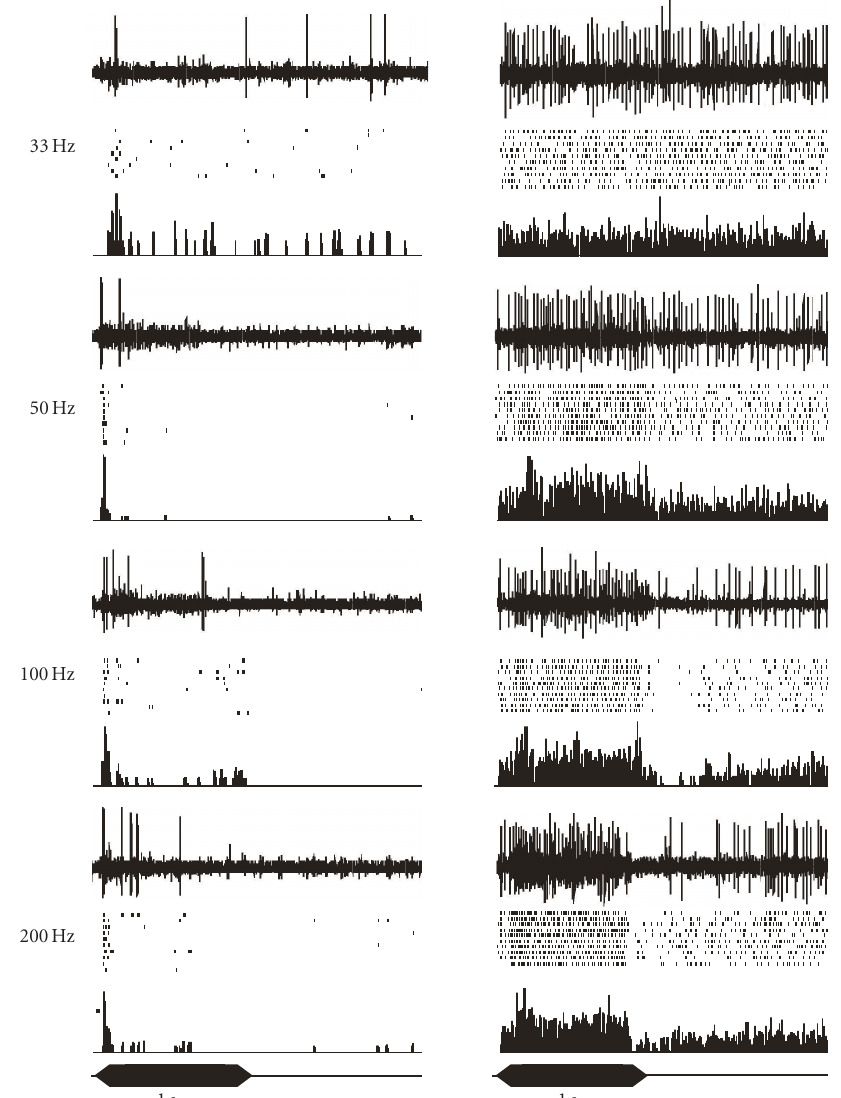
Figure 2: Examples of MON unit responses to a stationary sphere vibrating with 33, 50, 100 or 200Hz. Each graph shows an original recording, a dot display illustrating spike activity to ten stimulus presentations and a peri-stimulus time (PST) histogram (bin width 10ms). The envelope of the stimulus traces are shown at the bottom. Peak-peak displacement amplitude of the sphere was 160 μ m. Left; example of a phasic response. Right: example of a sustained